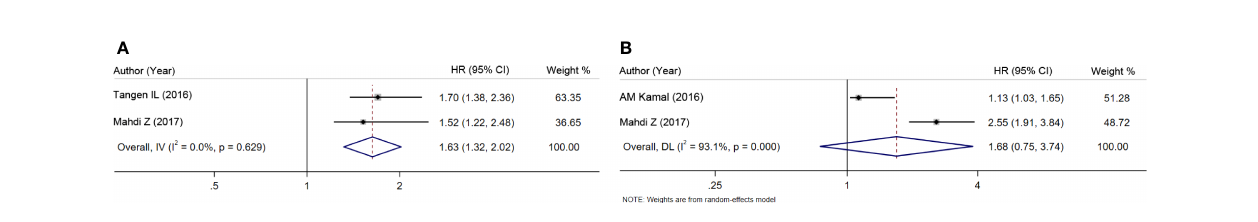
FIGURE 2 | Meta-analysis of the association between AR and patient survival. (A) Univariate survival analysis. (B) Multivariate survival